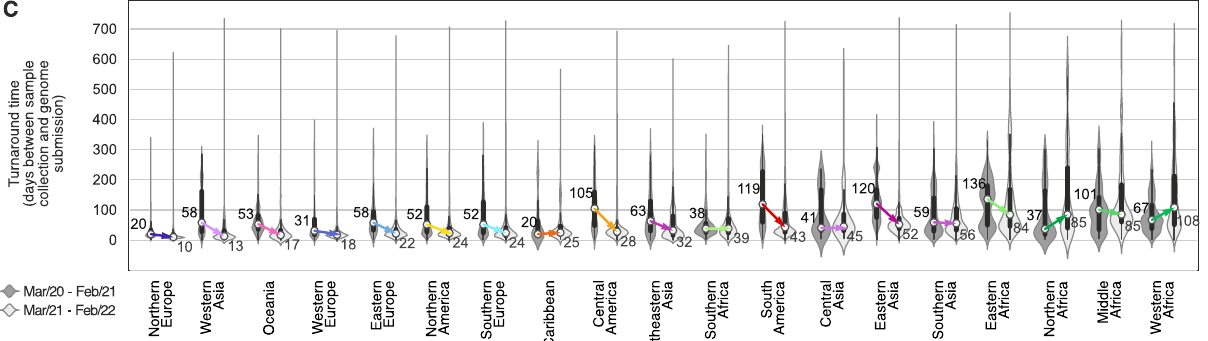
Fig. 2 | Genomic sequencing intensity and timeliness. A Frequency and overall percentage of sequenced cases per country (colored as in Fig. 1). This plot sum- marizesthedatashowninFig.1,wherethe x -axisshowsthepercentageofEWswith sequenced cases, and the y -axis displays the overall percentage of cases (shown in Fig. 1 as the rightmost column). Countries with the highest overall percentage of sequencedcasesineachregionarehighlightedusingtheISO3166-1nomenclature: NZL New Zealand, JPN Japan, BRN Brunei, MDV Maldives, TJK Tajikistan, ISR Israel, DNK Denmark, LUX Luxembourg, POL Poland, SVN Slovenia, EGY Egypt, GMBGambia,COGRepublicoftheCongo,DJIDjibuti,BWABotswana,CANCanada, NIC Nicaragua, BES Bonaire, and SUR Suriname. B Percentage of cases sequenced